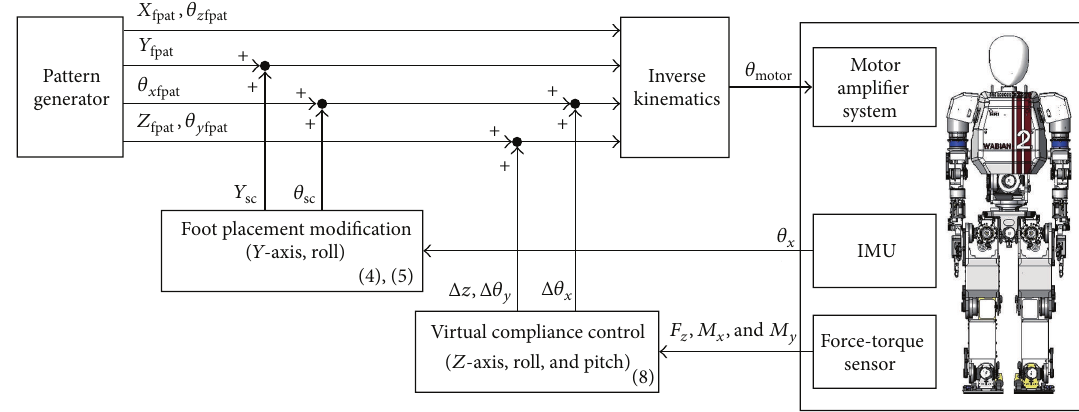
, 𝑌 , and 𝑍 are preset foot positions along the 𝑥 -, 𝑦 -, and 𝑧 -axes fpat fpat fpat